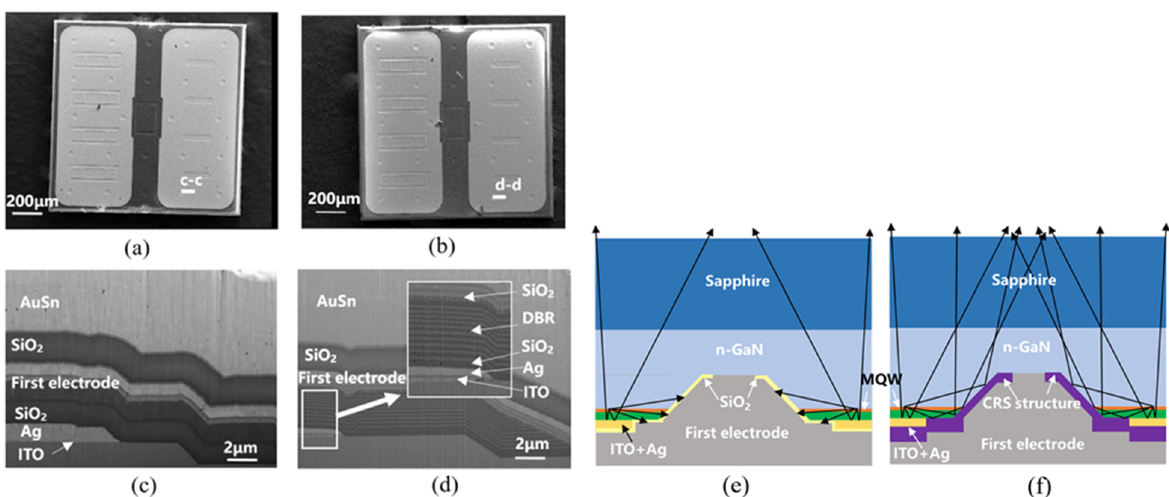
Figure 3. ( a ) Top-view SEM image of normal Ag-based FCLED. ( b ) Top-view SEM image of CRS-FCLED. ( c ) Cross-sectional SEM image of normal Ag-based FCLED milled by FIB along c-c direction. ( d ) Cross-sectional SEM image of CRS-FCLED milled by FIB along the d-d direction. ( e ) Schematic illustration of the light extraction of normal Ag-based FCLEDs. ( f ) Schematic illustration of the light extraction of CRS-FCLEDs.